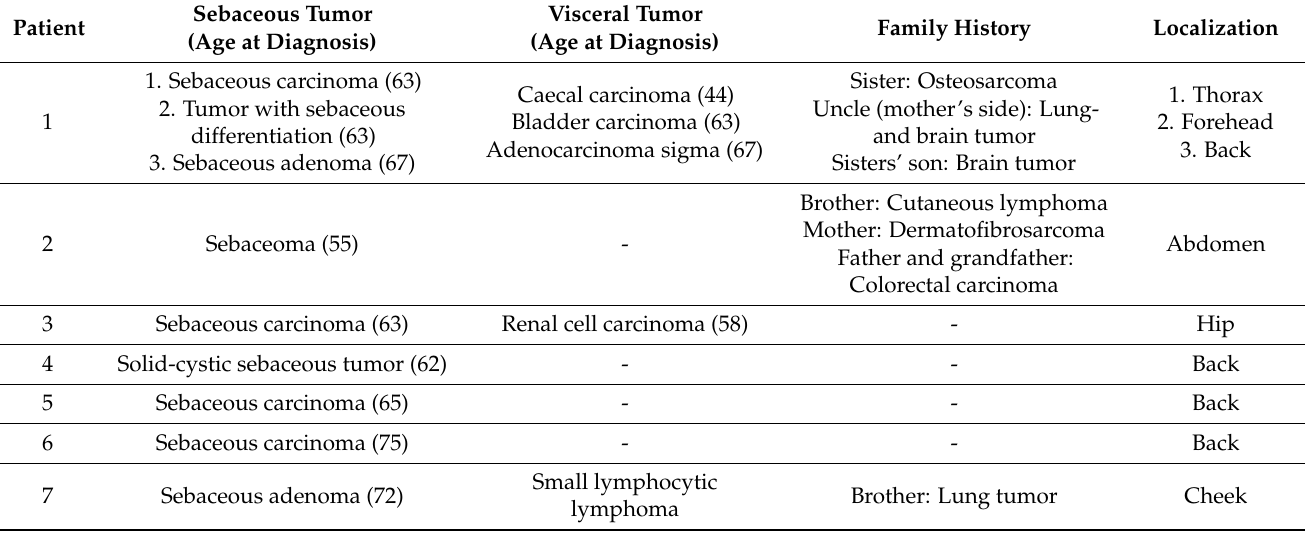
Table 2. Patients